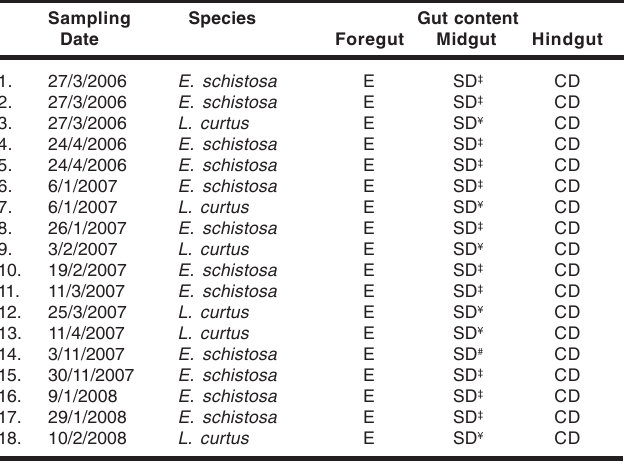
Table 4. Qualitative analysis of the gut contents of sea snakes collected in trawl catches of Goan coast Sampling